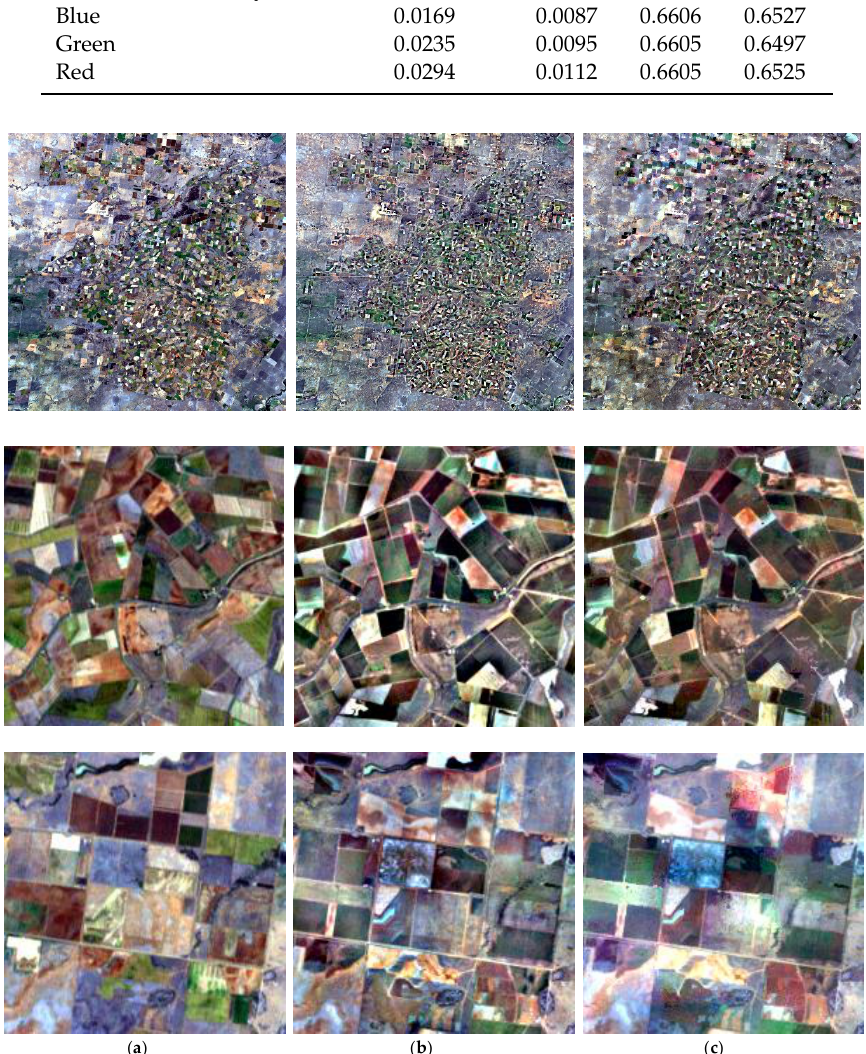
Figure 10. Fusion results for Coleambally irrigation area on 27 April 2002, zoomed to two changing irrigation areas (images in the 2nd row and the 3rd row). ( a ) Landsat at 30 m; ( b ) fused image at 30 m by HNN-SPOT; ( c ) fused image at 30 m by STARFM.